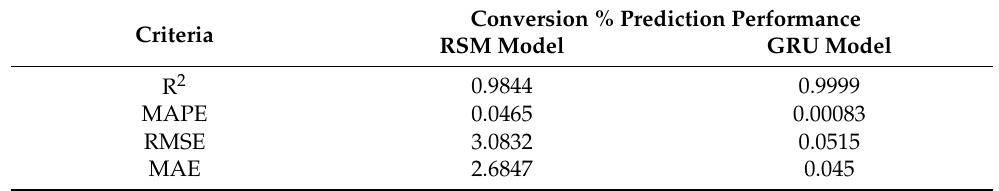
Figure 10. Gated recurrent unit model prediction. Table 5. Performance criteria comparison (response surface methodology vs. gated recurrent